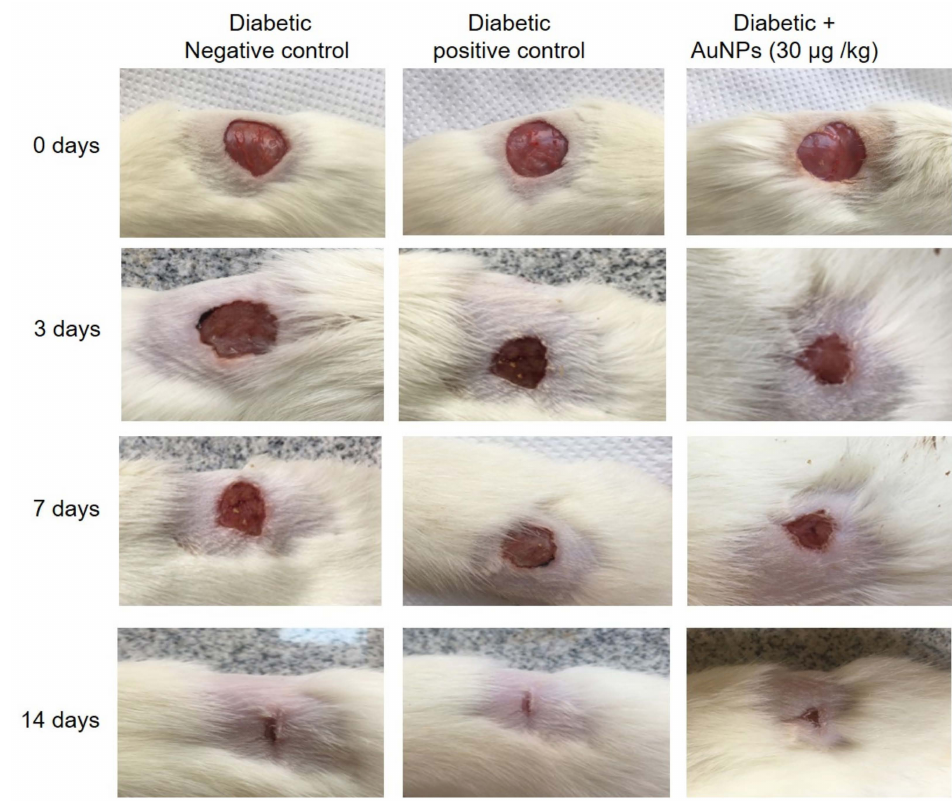
Figure 7. Photographic illustration showing the effect of topical application of AuNPs on wound healing on different days subsequent to the excision wound establishment in diabetic animals.